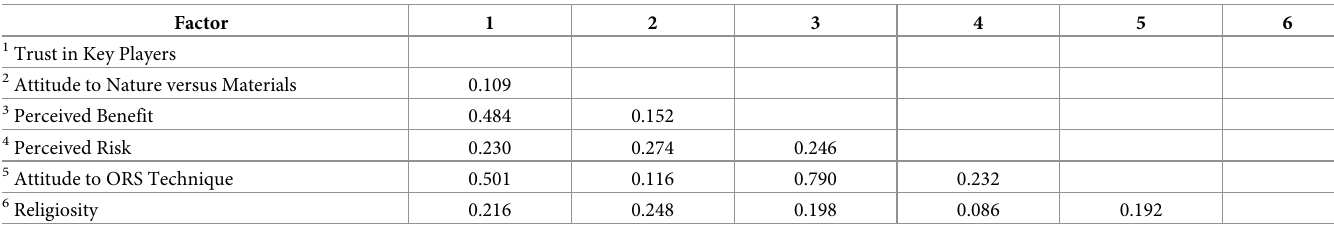
Eight hypotheses (H1 to H8) postulated the direct association between the predictors and atti- tudes towards the ORS approach, while three hypotheses (H9, H10, H11) tested the Table 5. HTMT Ratio Correlation.